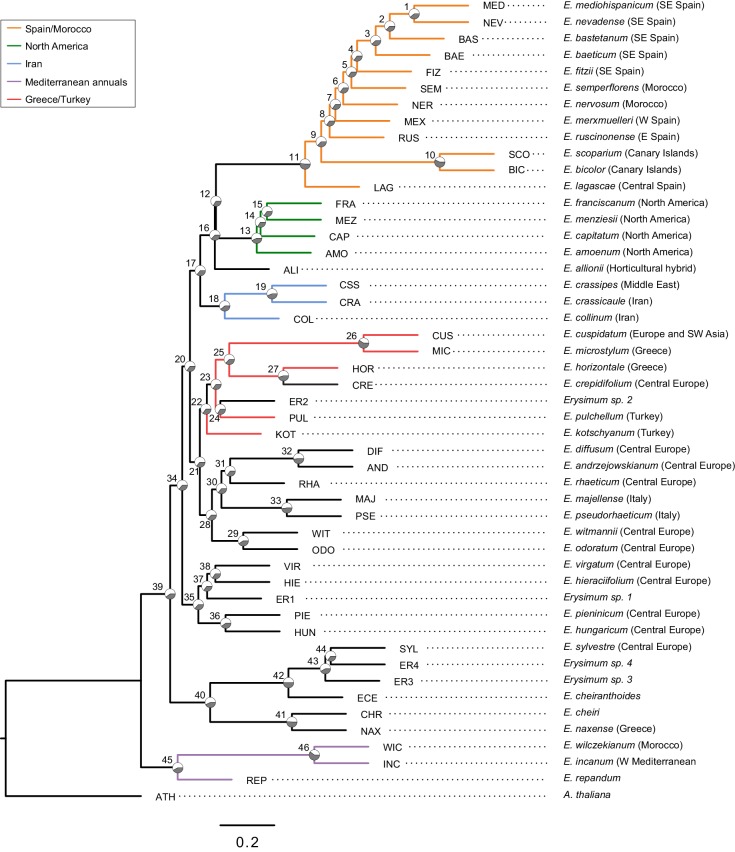
Genome-guided ASTRAL phylogeny of 48 Erysimum species.Phylogenetic relationships were inferred from 9868 orthologous genes using ASTRAL-III with Arabidopsis thaliana as outgroup. Pie charts on each internode show proportional quartet support for the main topology (q1) relative to the first and second alternative. Note that maximal discordance is indicated by equivalent support for each alternative (1/3). Nodes are labelled as 1 to 46; see Supplementary file 4 for full quartet support values and local posterior probability scores. Terminal branch length was manually adjusted to 0.2 coalescent units.